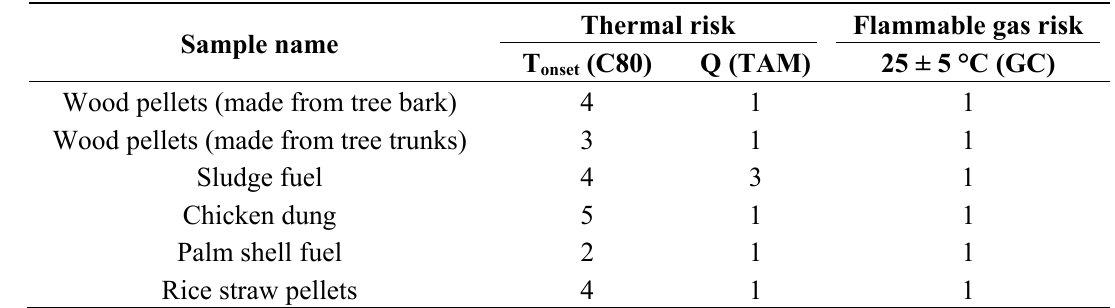
Table 4. Risk ranking of the tested samples.